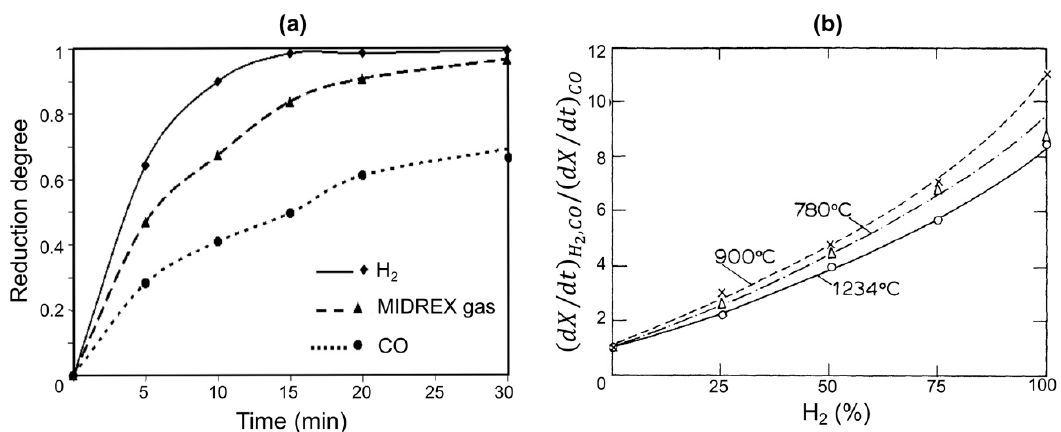
Figure 9. Comparison of the reduction kinetics of hematite pellets with H 2 , CO, and H 2 -CO mixtures. ( a ): reduction curves at 850 ◦ C (the MIDREX gas contains approx. 56%H 2 and 34% CO), data from [26]; ( b ): relative reduction rates at 55% conversion at 780, 900 and 1234 ◦ C as a function of the H 2 content in the H 2 -CO mixture, data from [25].